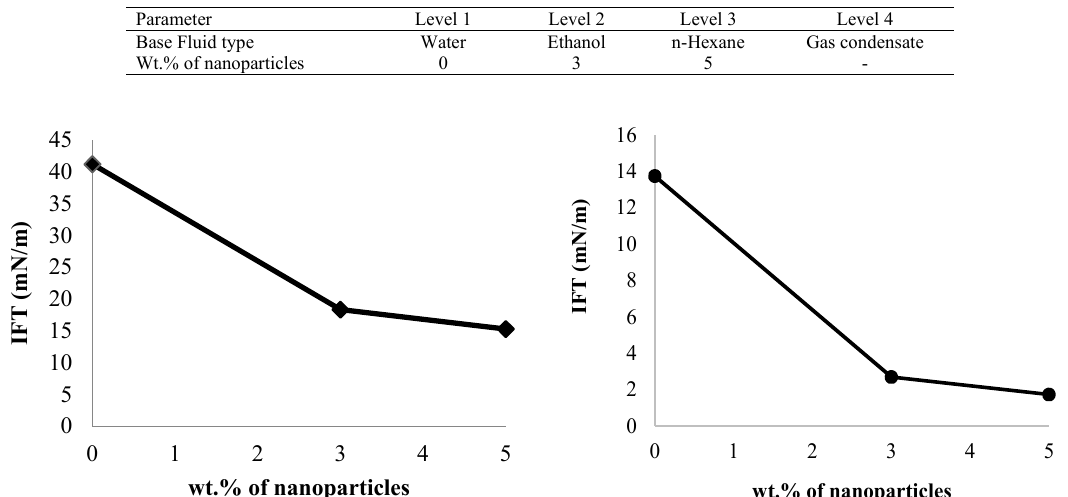
Table 3. Experiment design parameters and their levels